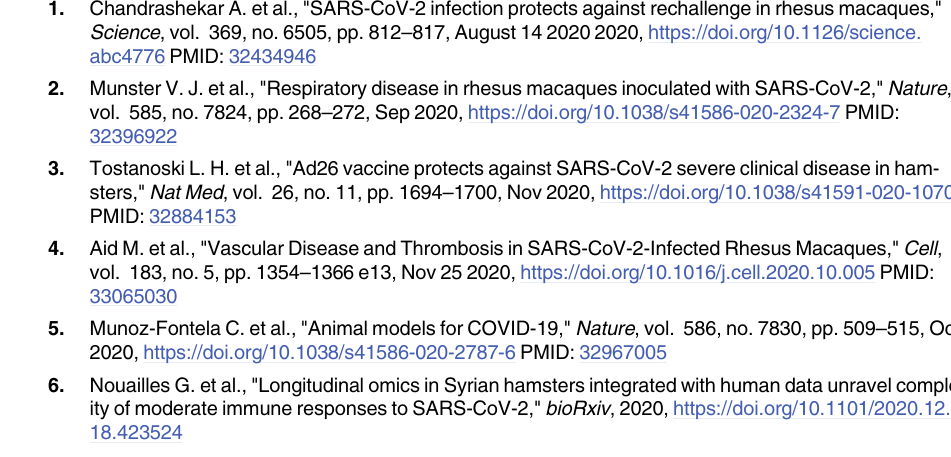
S1 Table. SARS-CoV-2 transcripts summarized in Fig 1A. S2 Table. Expression of genes on day 4 following SARS-CoV-2 challenge in hamsters sum- marized in S4